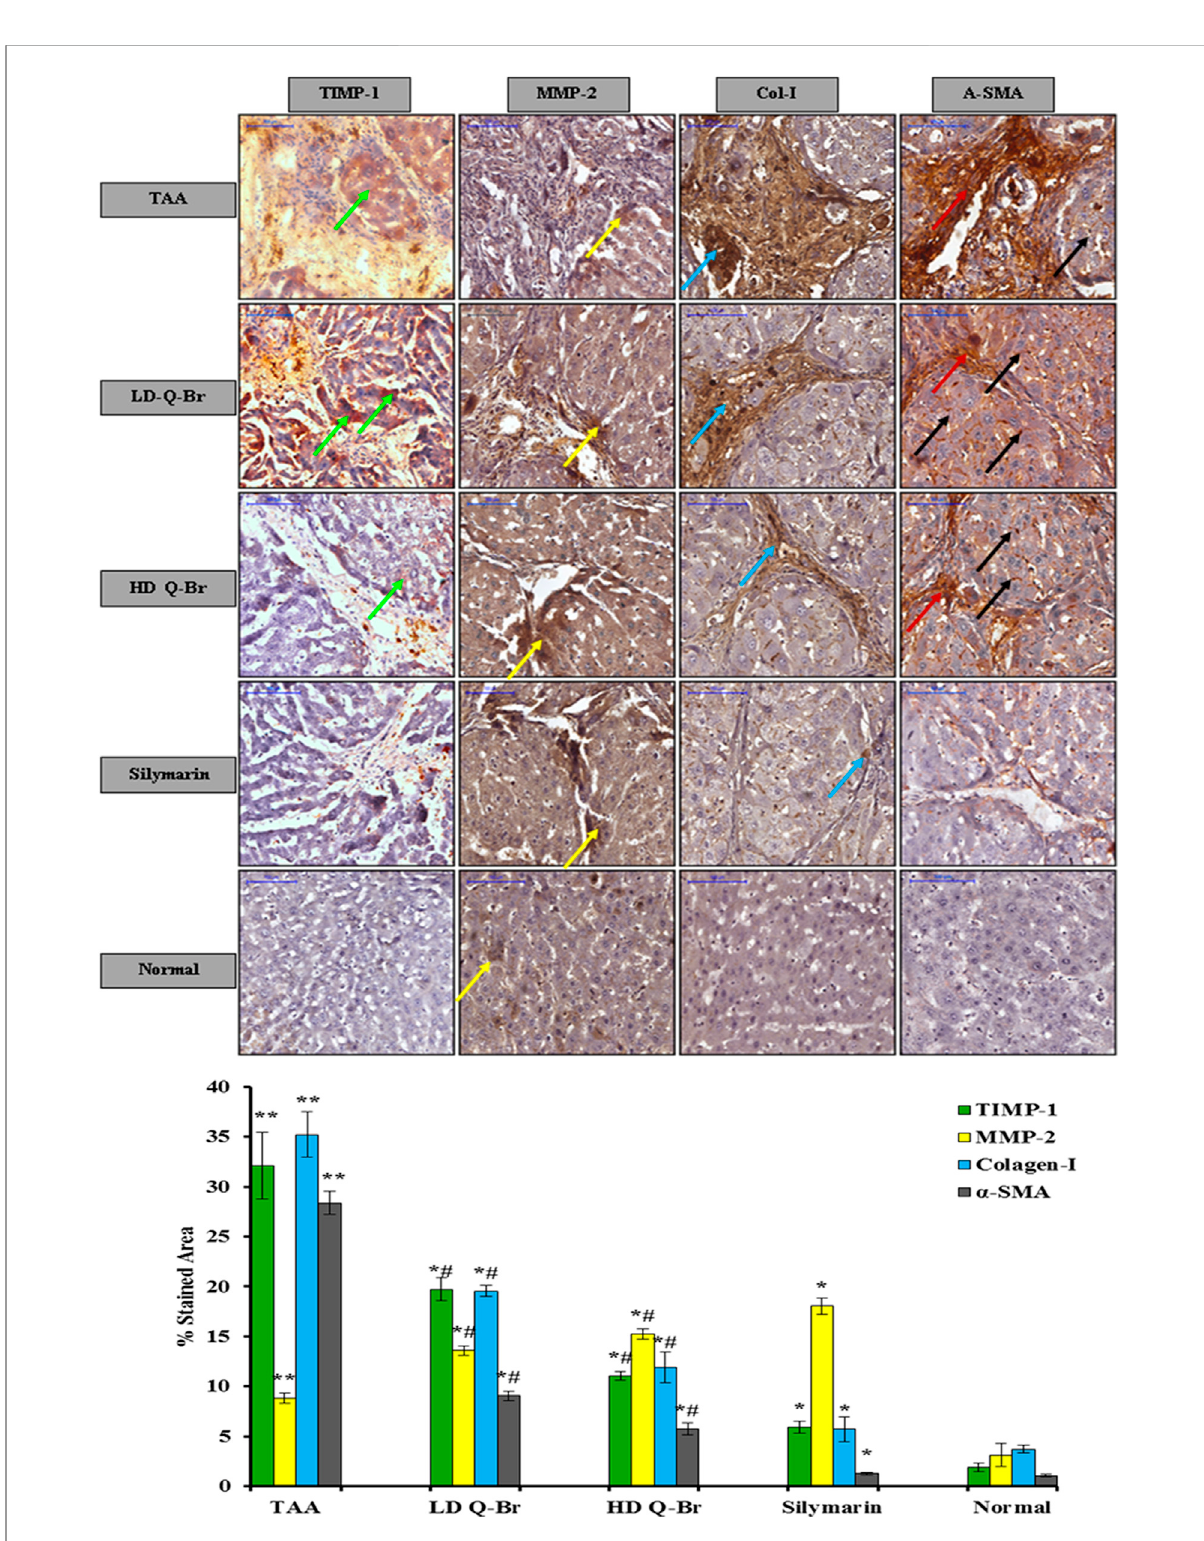
FIGURE 6 Q-Br treatment impact on the extracellular matrix protein family, tissue inhibitor of metalloproteinase (TIMP-1), metalloproteinase (MMP-2), and the hepatic stellate cells marker, alpha-smooth muscle actin ( α -SMA). Noticeable downregulation of TIMP-1 (green arrow), myo fi broblasts (red arrow), and α -SMA (black arrow) staining in the livers of rats treated with the low-dose (LD Q-Br, 25 mg/kg), high-dose (HD Q-Br, 50 mg/kg), and Silymarin (50 mg/kg) in comparison with that of the TAA control group which shows upregulation of the target antigens. On the other hand,